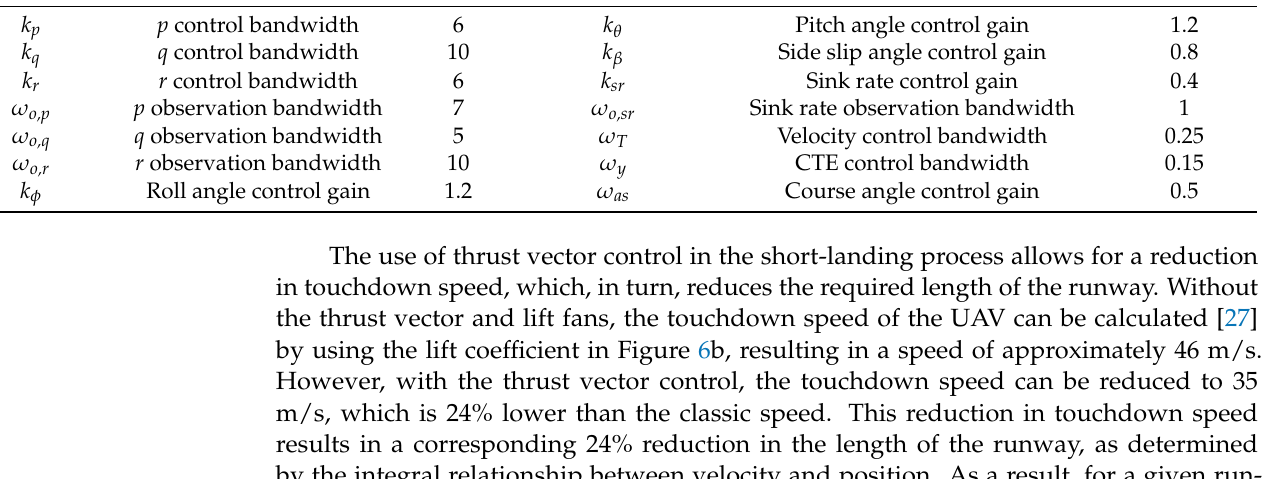
Figure 21. Three-dimensional trajectory of short landing.